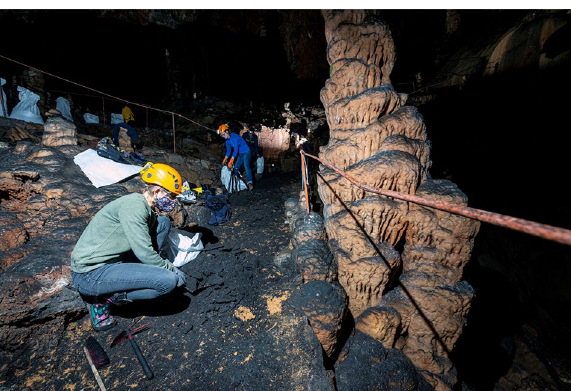
Figure 2. Removal of deposited CAFAS on tourist footpath in Divaška jama, 2019 (Photo: courtesy by Borut Lozej).